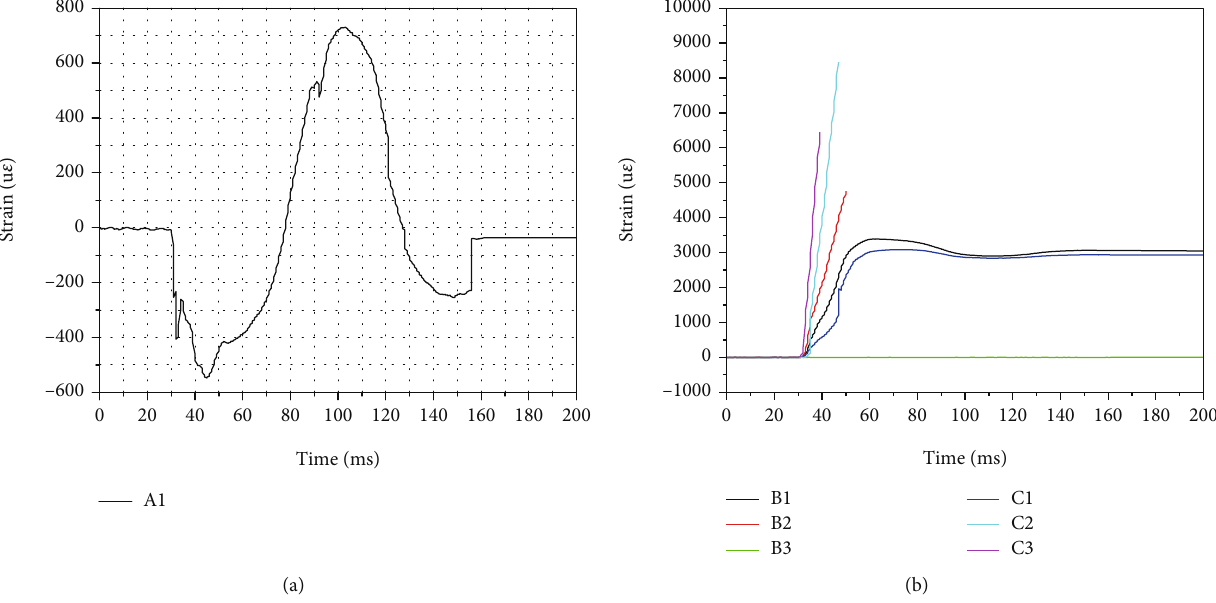
Figure 16: Monitored strains in the third shock: (a) vertical grating string; (b) transverse grating string.